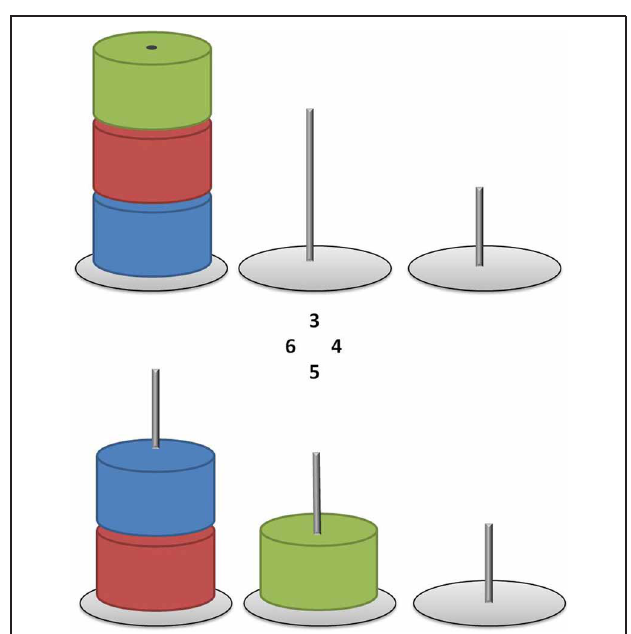
FIGURE A1 | An example stimulus from the adapted version of the tower of London—this stimulus represents a 5 move problem. Problems are presented under both safe and threat